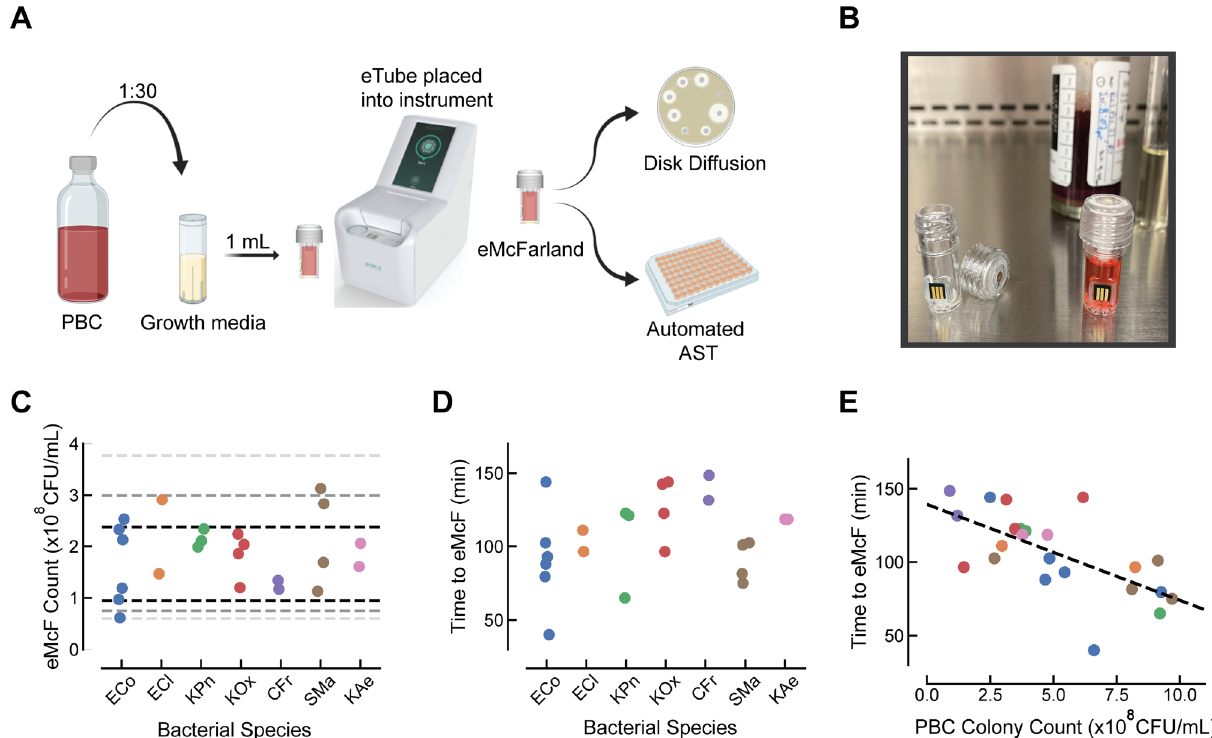
Figure 4. Automated eQUANT workflow and performance. The eQUANT method & instrument were used for automated eMcF generation from 23 positive blood cultures spiked with seven different species— E. coli (ECo), E. cloacae (ECl), K. pneumoniae (KPn), K. oxytoca (KOx), C. freundii (CFr), S. marcescen s (SMa), and K. aerogenes (KAe). ( A ) Illustration of the eQUANT workflow. An aliquot of a PBC is diluted 1:30 in growth media, transferred into the eTube and inserted into the eQUANT instrument. The organism ID is selected from the menu, and the species-specific algorithm is used for eMcF generation. The resulting standardized inoculum is then used for inoculation of conventional AST (e.g. automated AST platforms, Kirby-Bauer Disk Diffusion). ( B ) Photo of the eTube consumable with integrated ORP sensor, unfilled with cap removed (left) and filled with a diluted positive blood culture sample (right). ( C ) The resulting eMcF samples were plated and colonies were counted to determine the bacterial concentration. The dotted lines represent the error ranges of the targeted 1.5 × 10 8 CFU/mL concentration for all species tested (± 0.2log, ± 0.3log, ± 0.4log). ( D ) Time to eMcF for all samples were recorded and ranged from 40 to 149 min with an average time of 106 ± 28 min. ( e ) Time to eMcF was plotted as a function of PBC colony counts for each species, and a Pearson Correlation was performed (dotted line). The resulting Pearson coefficient of -0.65 indicates a moderate negative correlation between time to eMcF and PBC starting